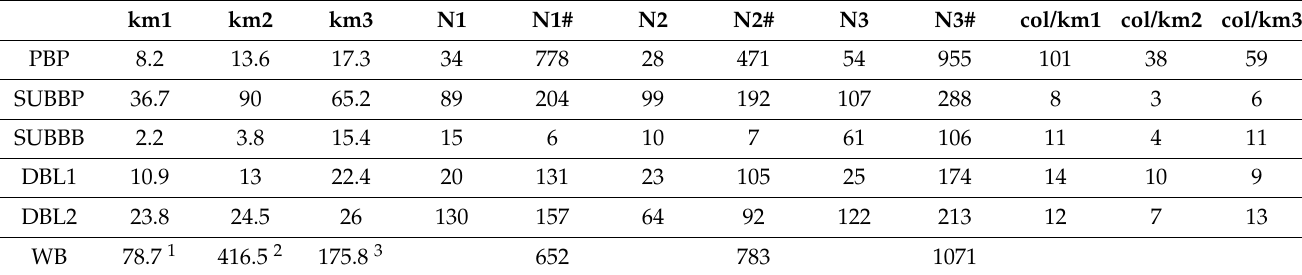
km1: length of the bikeway type in districts FH and KB. km2: length of the bikeway type in districts PB, WS, and PK. km3: length of the bikeway type in districts MI, TG, and WD. N1: number of bicycle collisions with motorized vehicles within bikeway type, on road sections in districts FH and KB. N1#: bicycle collisions with motorized vehicles within bikeway type, at road intersections. N2: bicycle collisions with motorized vehicles within bikeway type, on road sections in districts PB, WS, and PK. N2#: number of bicycle collisions with motorized vehicles within bikeway type, at road intersections in districts PB, WS, and PK. N3: number of bicycle collisions with motorized vehicles within bikeway type, on road sections in districts MI, TG, and WD. N3#: number of bicycle collisions with motorized vehicles within bikeway type, at road intersections in districts MI, TG, and WD. col./km1: bicycle collision with motorized vehicle frequency rate [(N1 + N1#)/m1] for bikeway type in districts FH and KB. col./km2: bicycle collision with motorized vehicle frequency rate [(N2 + N2#)/m2] for bikeway type in districts PB, WS, and PK. col./km3: bicycle collision with motorized vehicle frequency rate [(N3 + N3#)/m3] for bikeway type in districts MI, TG, and WD. 1 This value considered the 160 km of public roads in FH and KB (Senate, 2006), discounting